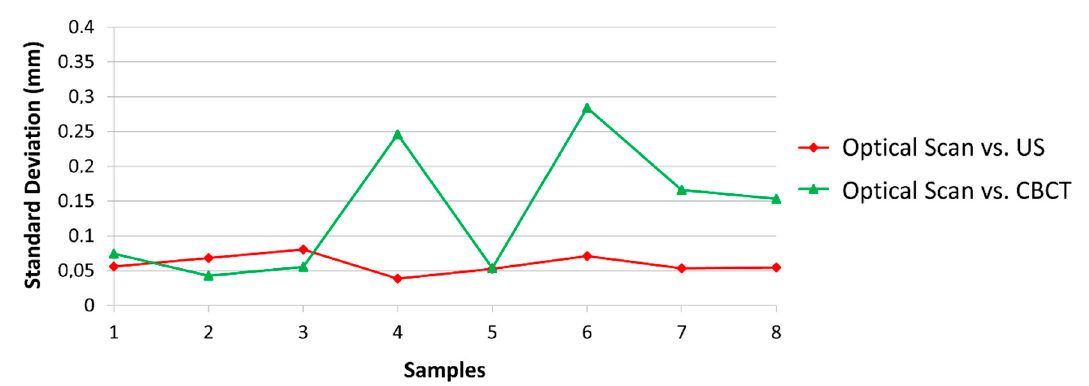
Figure 7. Standard deviation of all samples in relation to the optical scan. CBCT: cone-beam computed tomography; US: ultrasound.